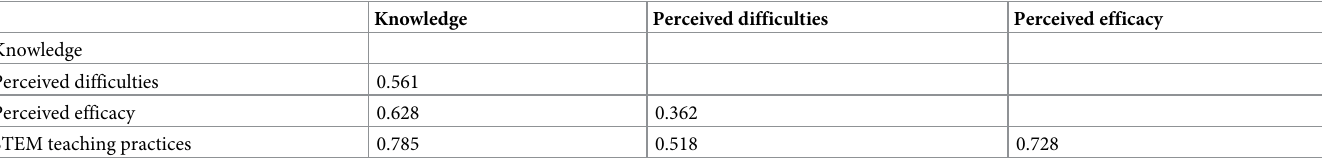
Table 2. Heterotrait-monotrait ratio of correlations, construct reliability, and validity of